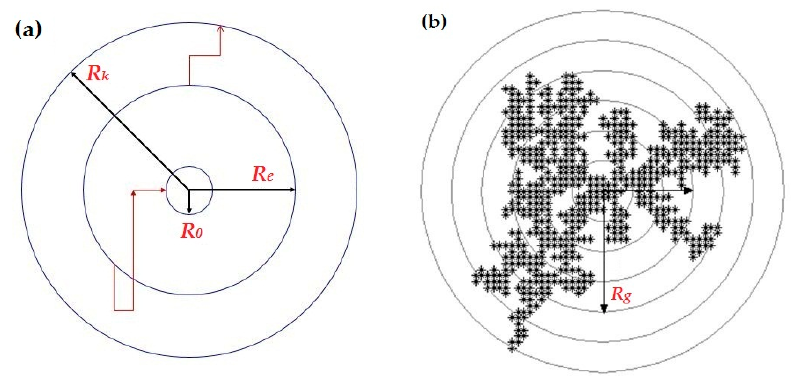
Figure 1. Sketch of particle aggregation of DLA model ( a ) and fractal dimension calculation by using gyration method ( b ).